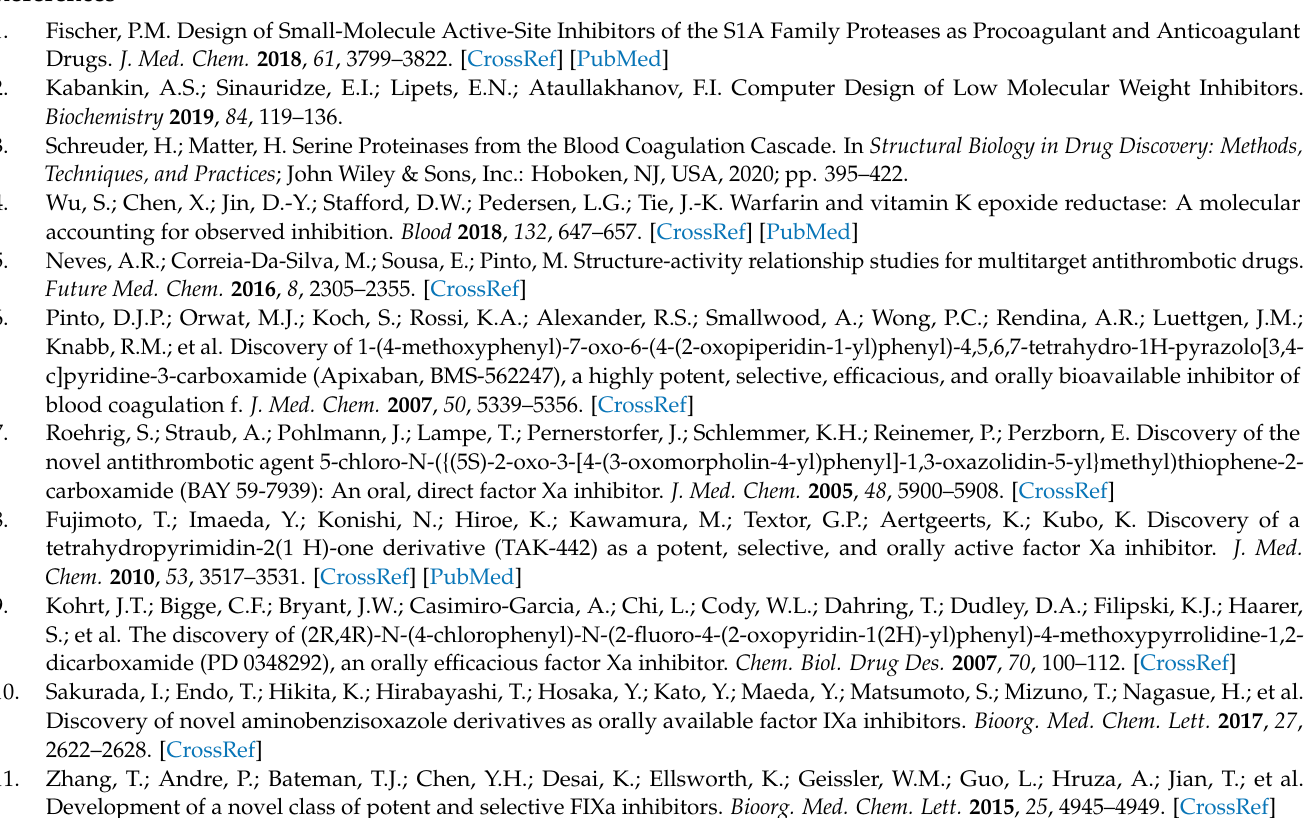
Figure S1: The cascading mechanism of blood coagulation process; Figure S2: The overall structural deformations of the binding site of the two sets of proteins; Figure S3: Catalytic Triad; Figure S4: The conserved and non-conserved residues on the aligned sequences; Figure S5: The cognate docking poses; Figure S6: RMSD plot of all the FIXa and FXa proteins; Figure S7: The total energy of the complex; Figure S8: Radius of Gyration plot for FIXa and FXa; Figure S9: RMSF plot for FIXa and FXa, Table S1: Cross docking data with FIXa grids; Table S2: Cross docking data with FXa grids; Table S3: ADMET descriptors for twelve co-crystalized structures using